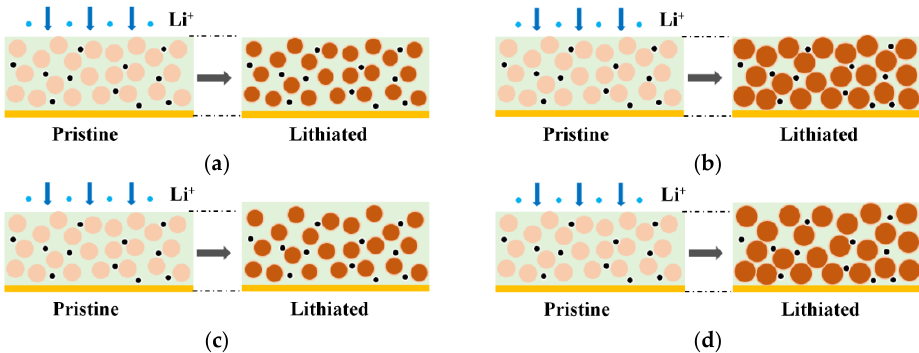
Figure 1. Schematics of electrode structures during lithiation with ( a ) no change in porosity and volume, ( b ) variable porosity and invariable volume, ( c ) variable volume and invariable porosity, and ( d ) variable porosity and volume.